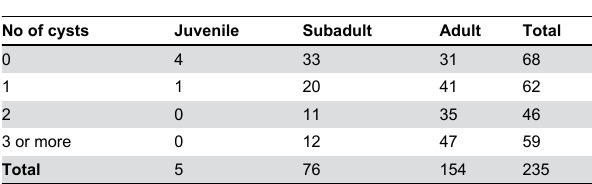
Table 1. Number of investigated male otter spermatic ducts between 1999 and 2011, presented with number of cysts present, and number of otters divided into the age classes: juvenile, subadult and adult.